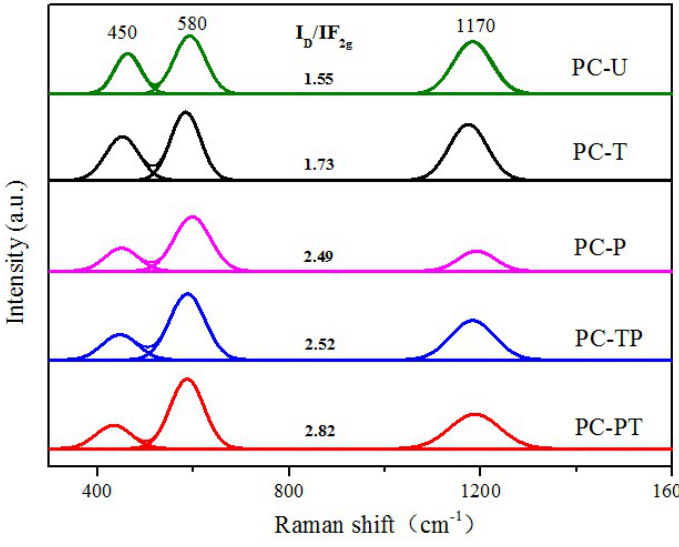
Figure 8. Raman spectra of different Pt/CeO 2 samples.